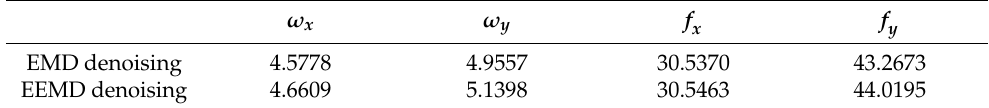
Table 5. PSNR effect